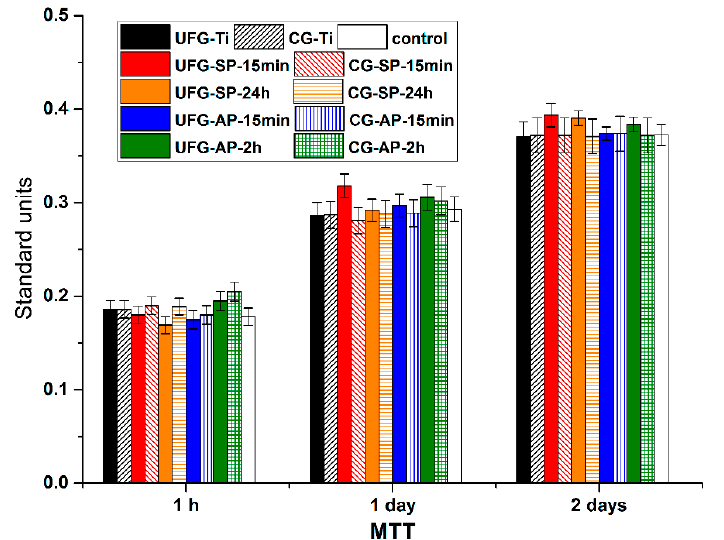
Figure 5. MG-63 cells viability after co-incubation on UFG and CG titanium. Data are presented as mean ± S.D. from five independent series of experiments ( p < 0.05).